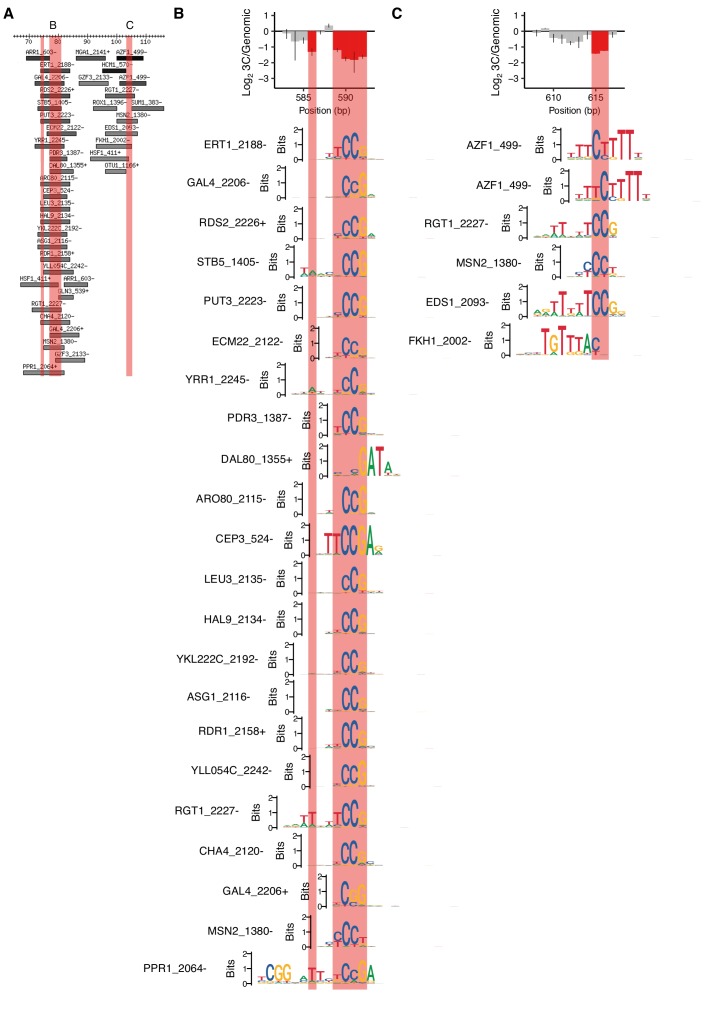
Lower-scoring motifs matching positions required for HAS1pr-TDA1pr pairing.(A) Motifs overlapping region of HAS1pr-TDA1pr containing positions required for pairing, zooming into the clusters of positions not shown in Figure 1—figure supplement 2. Coordinates are relative to 511 bp upstream of the HAS1 coding sequence in S. cerevisiae (sacCer3). All ‘expert-curated no dubious’ motifs from YeTFaSCo (de Boer and Hughes, 2012) scoring at least 45% of the maximum possible score are shown. B and C indicate regions highlighted in other panels. Pink regions indicate positions required for HAS1pr-TDA1pr pairing (same as in Figure 1D). (B–C) Sequence logos of motifs spanning the cluster of positions required for pairing are shown aligned relative to the error-prone PCR cis MAP-C data from Figure 1G and H, in the same vertical order as in panel A.